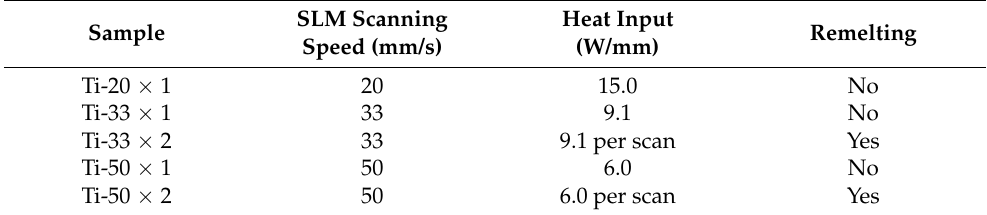
Figure 2. ( a ) Scheme of the build orientation of the manufacture samples and ( b ) a Ti6Al4V manufac- tured sample. Table 1. Manufacturing conditions used in the manufactured